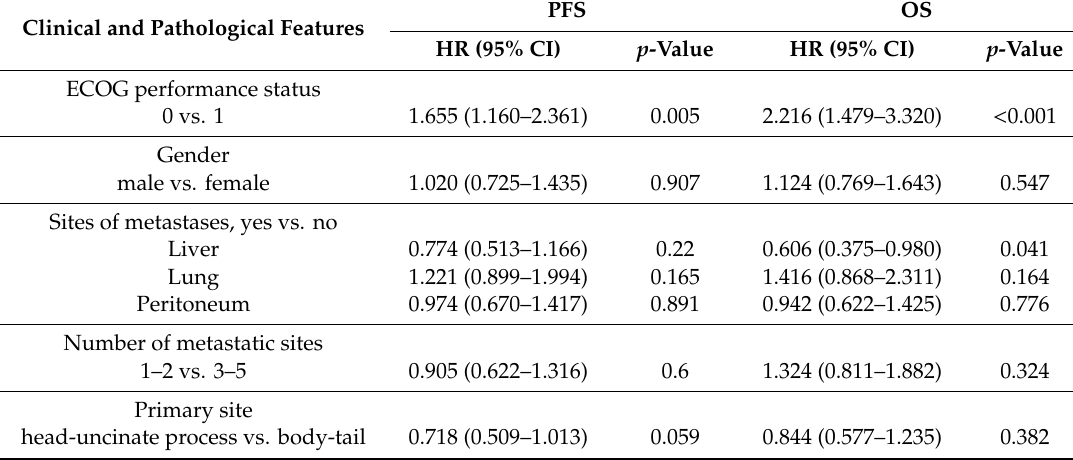
Table 3. Impact of clinical and pathologic features on PFS and OS (univariate analysis) in the whole